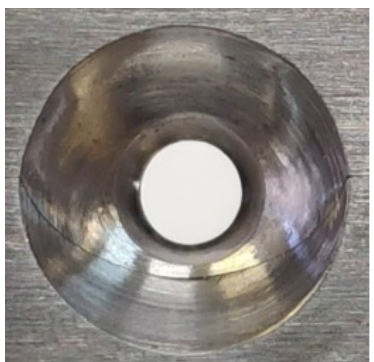
Figure 14. Geometric issues function as a major contributor to failure mode by fracture.